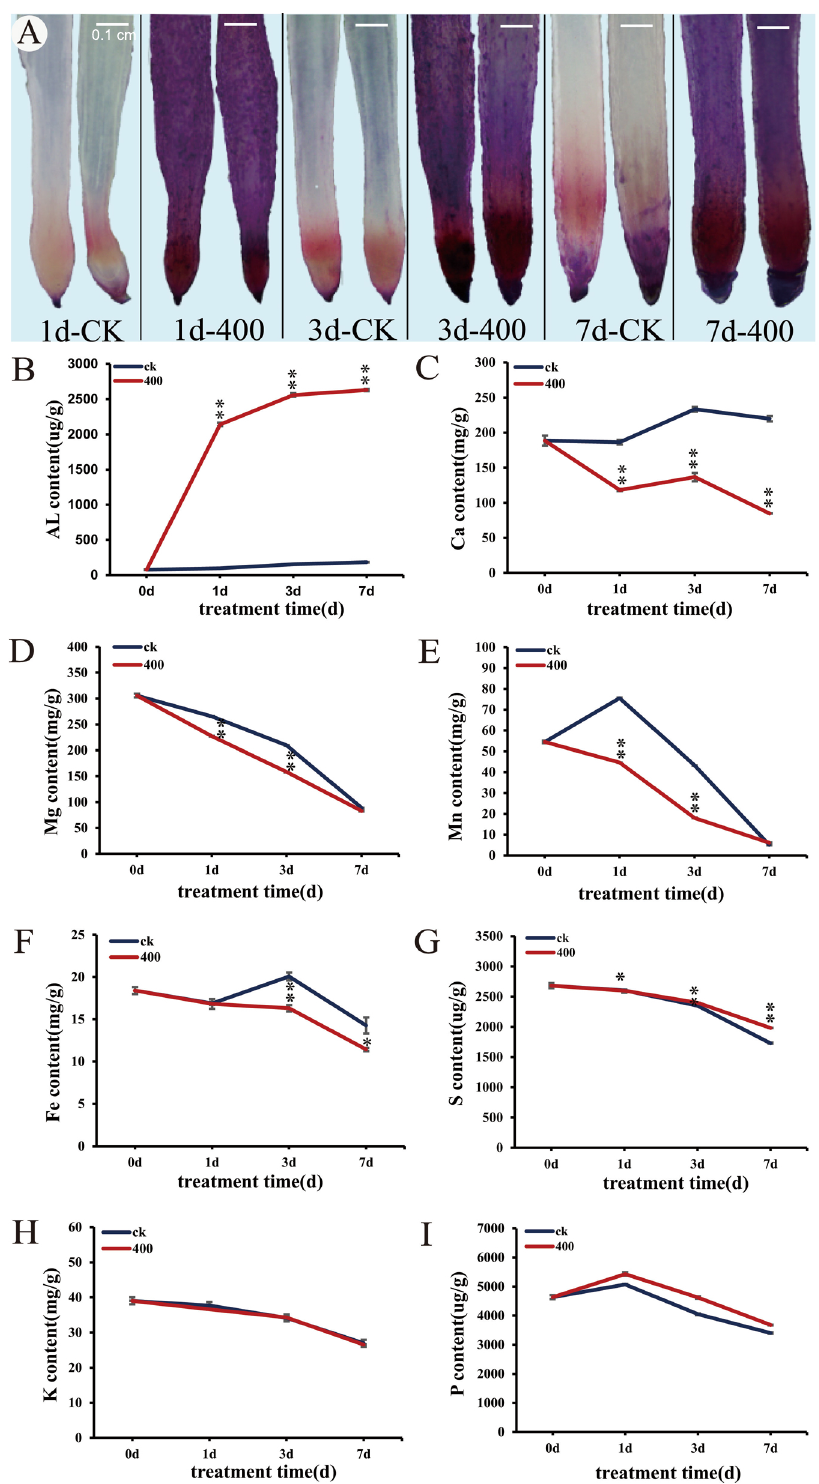
Figure 3. Absorption and distribution of aluminum by root tip. ( A ) Distribution of aluminum in root tip in di ff erent periods; the length of the root tip is 1 cm. Eriochrome cyanine R staining does not show red and brown as the control group, but shows red and blue as the treatment group. ( B – I ) Changes of element concentration in root tip. The error line represents the average ± SD of the three organisms (Students’ t -test, * p < 0.05, ** p <